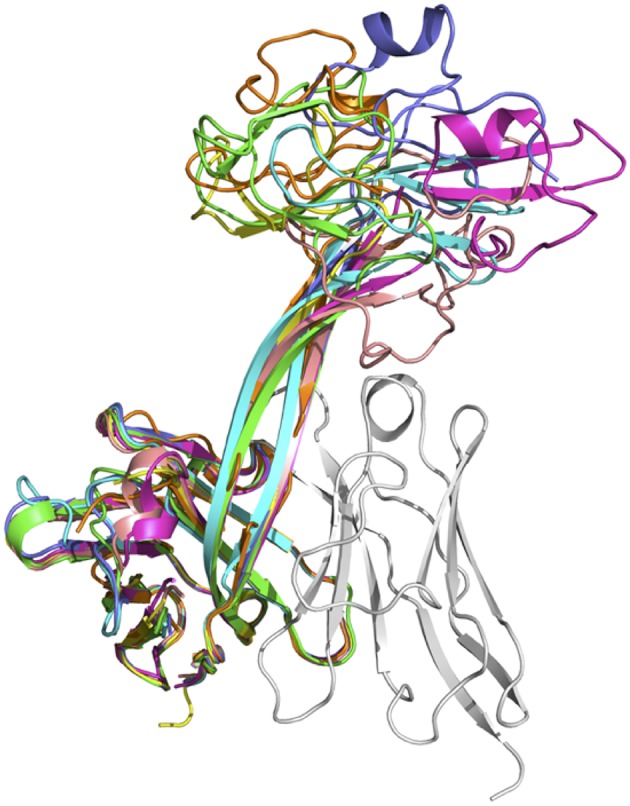
Superimposition of seven crystal structures of bovine heavy chain variable domains. Antibody BOV-1 is in green, BOV-2 in orange, BOV-5 in cyan, BOV-4 in magenta, BOV-6 in yellow, BOV-3 in light blue, and BOV-7 in pink. The light chain variable domain of antibody BOV-2 is shown in gray for reference.